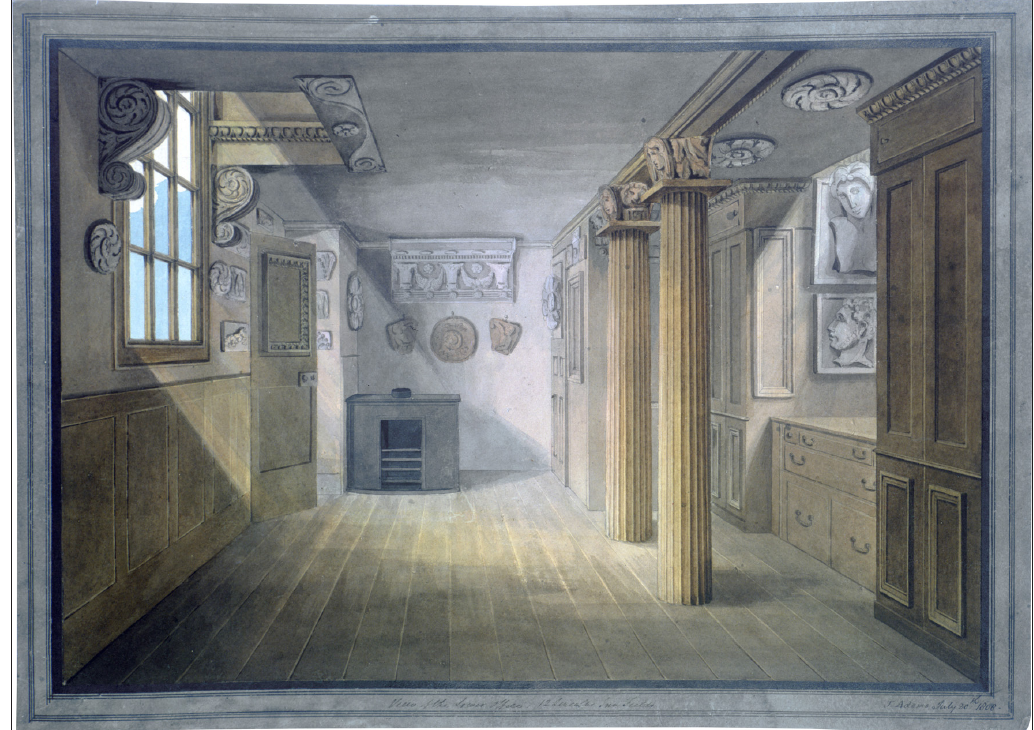
Fig. 2 : James Adams, View of the lower office at 12 Lincoln’s Inn Fields, 20 July 1808, watercolour on paper, Sir John Soane’s Museum SM Vol. 83/33.